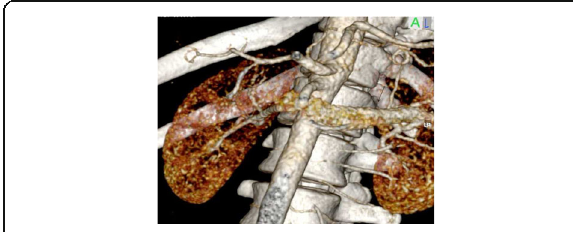
Fig. 2 AVF treatment. Angio-CT 3D V. R. reconstruction